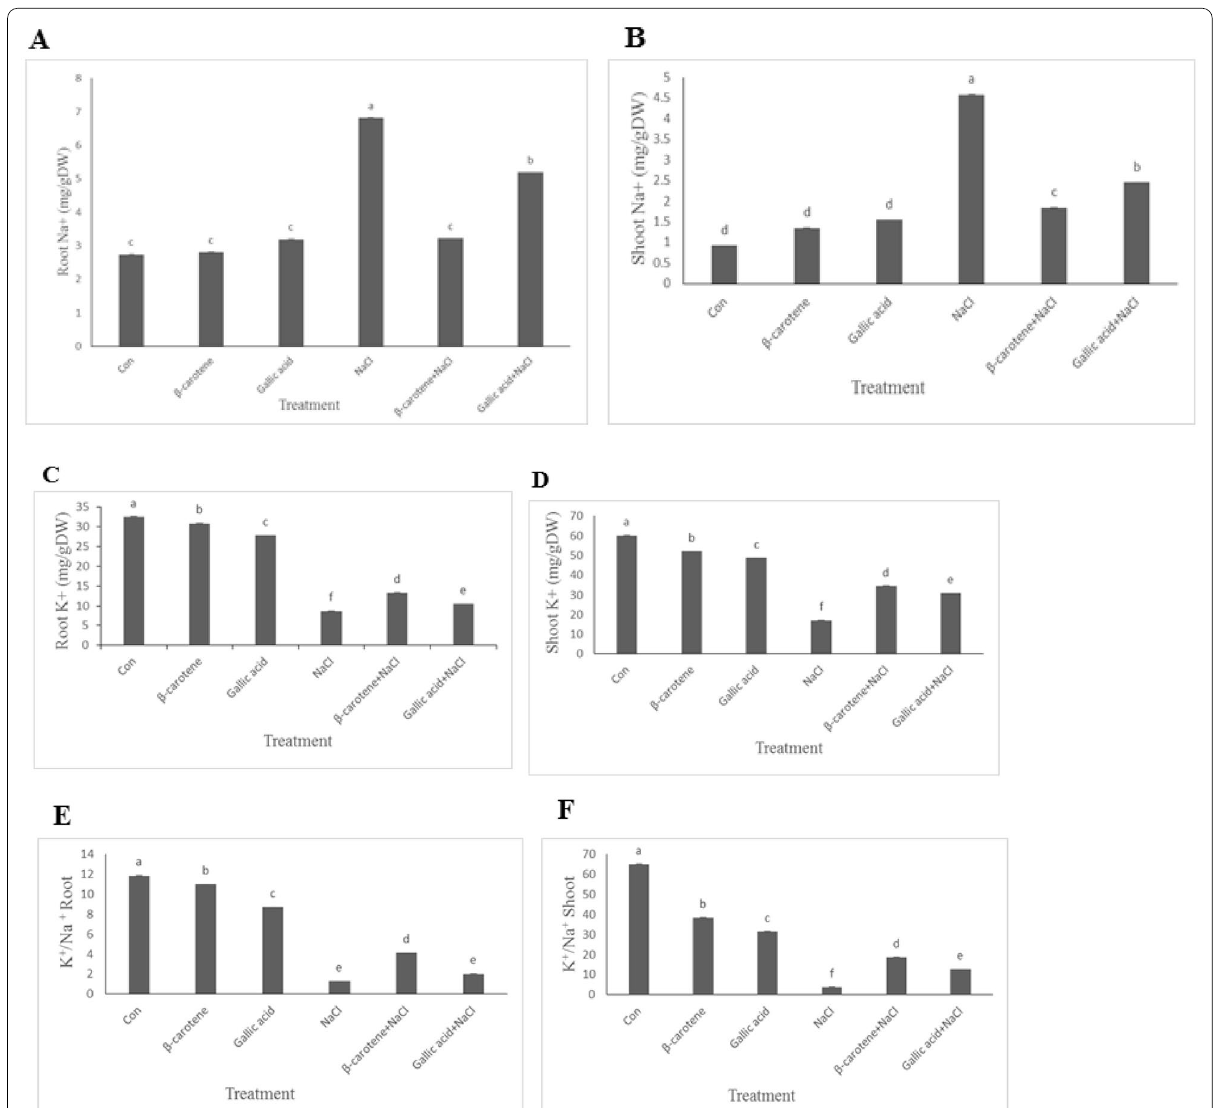
Fig. 7 Effect of β‑carotene and gallic acid, under saline and non‑saline conditions on Na + concentration in roots ( A ), shoots ( B ), K + concentration in roots ( C ), K + in shoots ( D ), K + /Na + ratio in roots ( E ), K + /Na + ratio in shoot ( F ) in Lepidium sativum seedlings. Columns with the same letters are not statistically different at 5% probability using Duncan’s